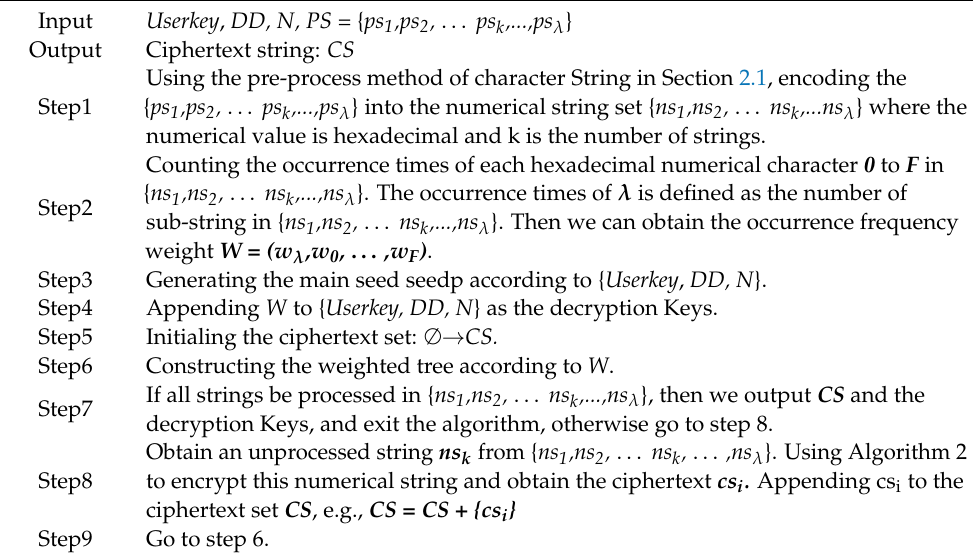
Algorithm 3: The encryption scheme of